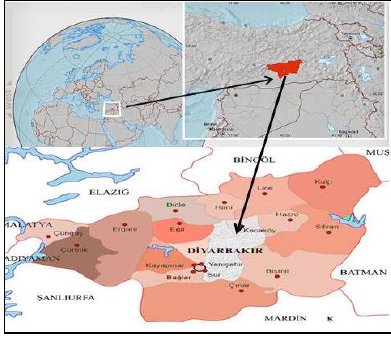
Figure 1. Location of Diyarbakır [15].